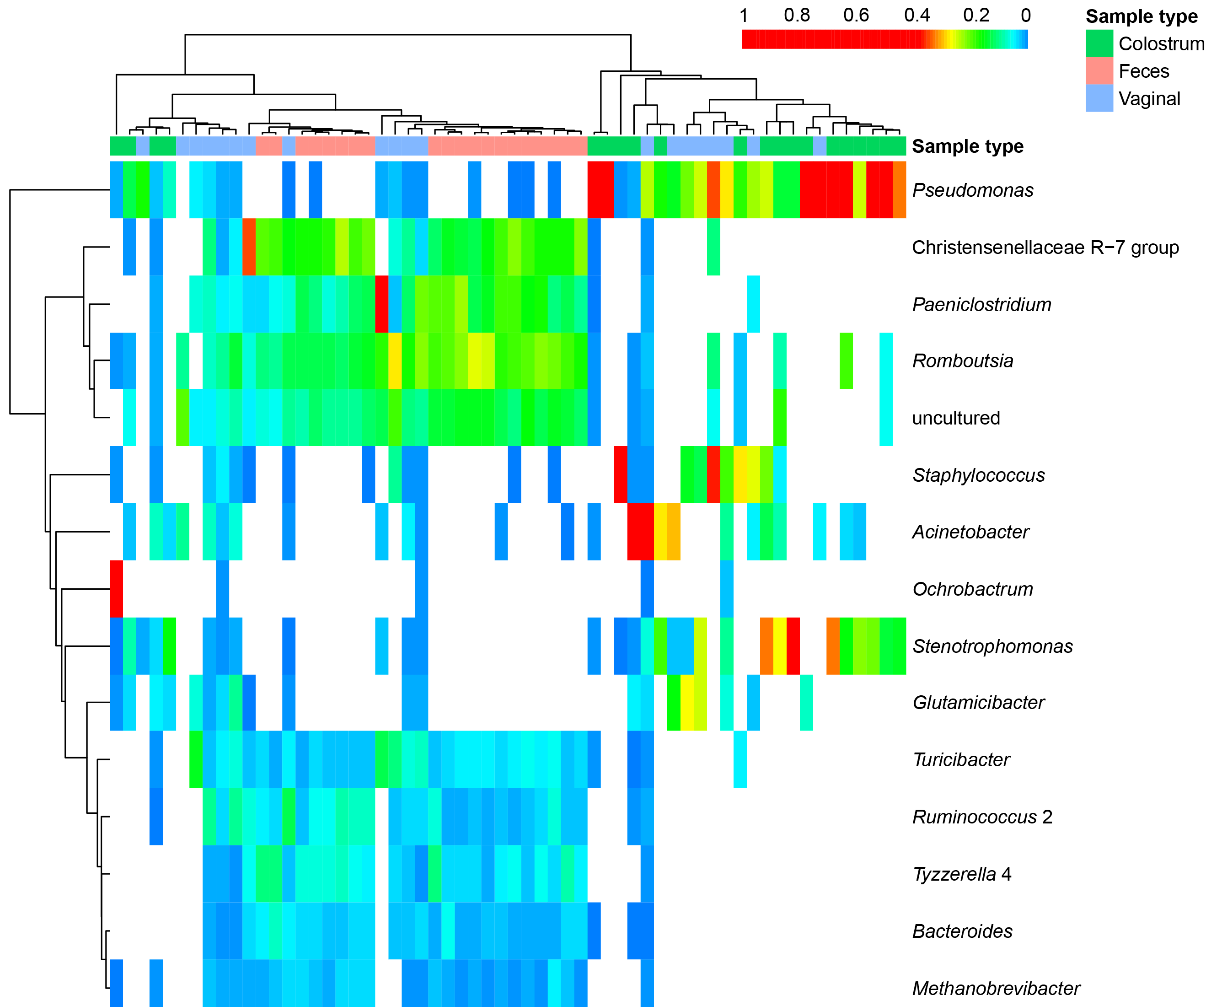
Figure 2. A heat map showing the major bacterial taxa found in samples collected from 20 Holstein cows at parturition. Each row refers to a taxon (genus) and each column represents a sample (as listed in code below the map). The color legend at the top of the graph indicates the type of sample evaluated (colostrum, fecal or vaginal).